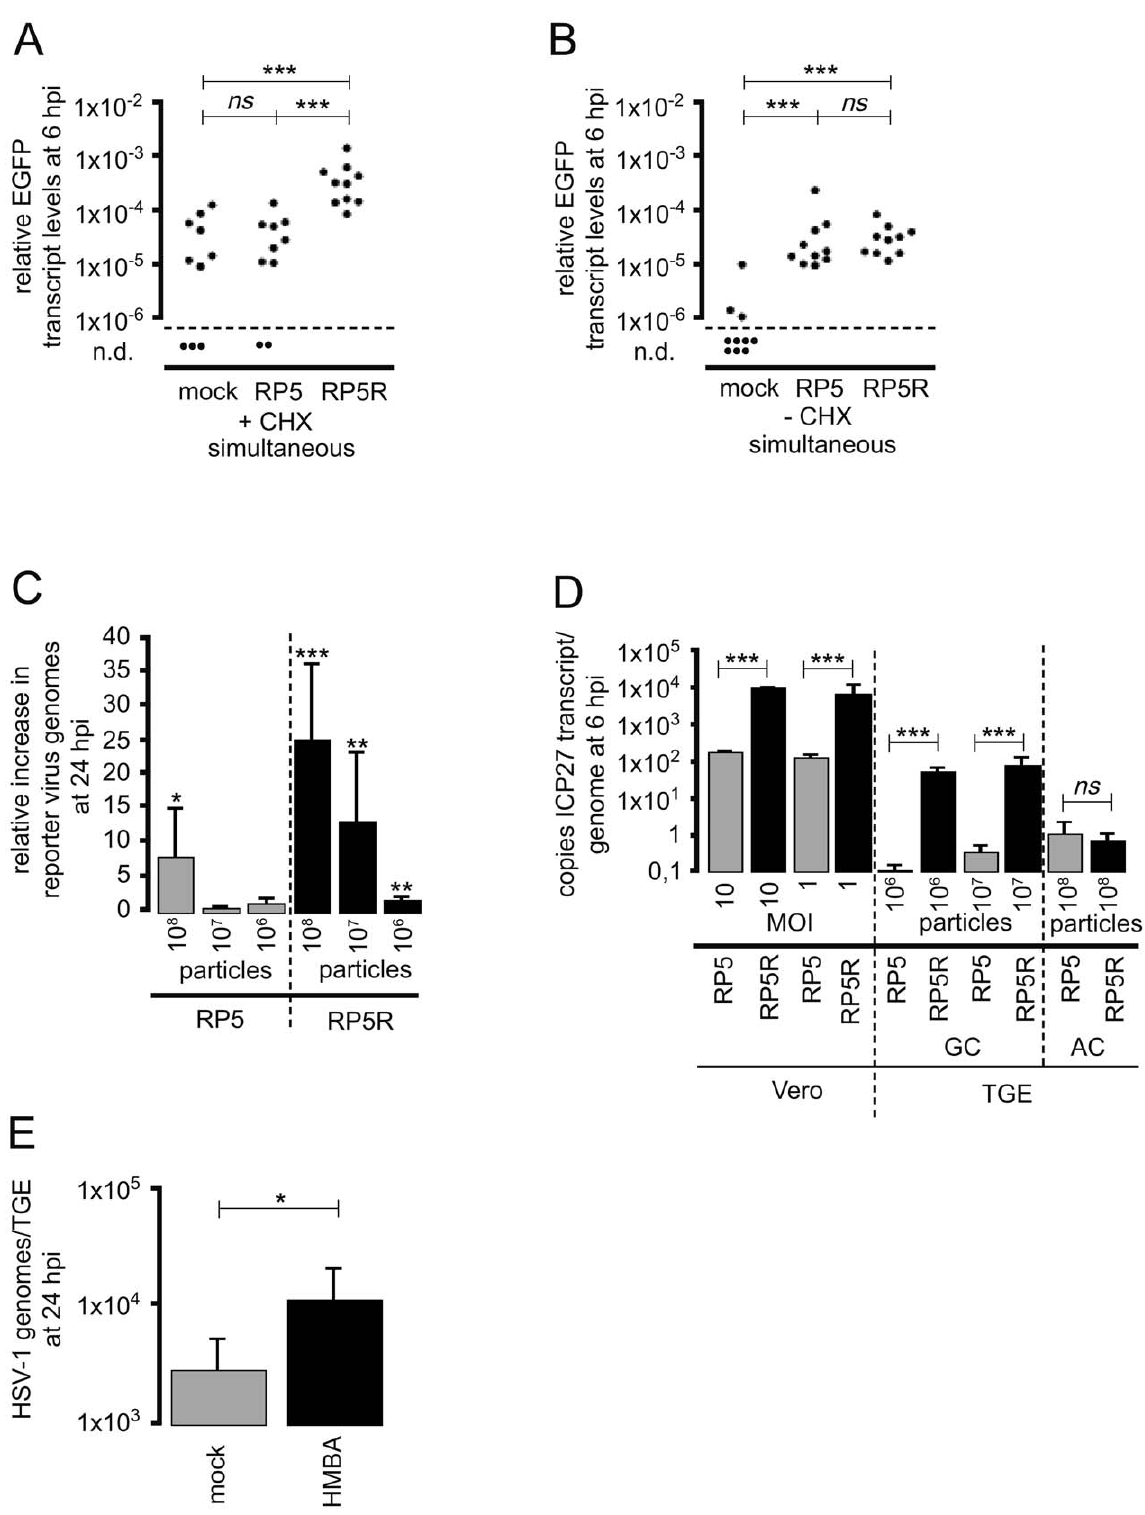
Figure 6. Infection of TGEs by the VP16AD-deficient mutant HSV-1 KOS RP5. (A) Transactivation of HSV-1 IE gene expression by HSV-1 KOS RP5 in the absence of de novo protein synthesis. Cultures were infected in the AC with 5 6 10 6 pfu of HSV-1 17 IE4proEGFP in the presence of 50 m g/ ml CHX. Groups of ten cultures were co-infected in the GC with identical numbers of particles of HSV-1 KOS RP5 or the revertant HSV-1 KOS RP5R (1 6 10 8 particles, corresponding to 5 6 10 6 pfu of HSV-1 KOS RP5R). Cultures without helper-virus co-infection served as controls. Cultures were harvested at 6 hpi, and the relative transcript levels of EGFP were determined. The statistical significances of differences in the mean relative transcript levels are indicated (mock vs. HSV-1 KOS RP5, P =0.8352; mock vs. HSV-1 KOS RP5R, P , 0.0001; HSV-1 KOS RP5 vs. HSV-1 KOS RP5R P , 0.0001; unpaired t test with Welch correction), ns (not significant). (B) Transactivation of HSV-1 IE gene expression by HSV-1 KOS RP5 without